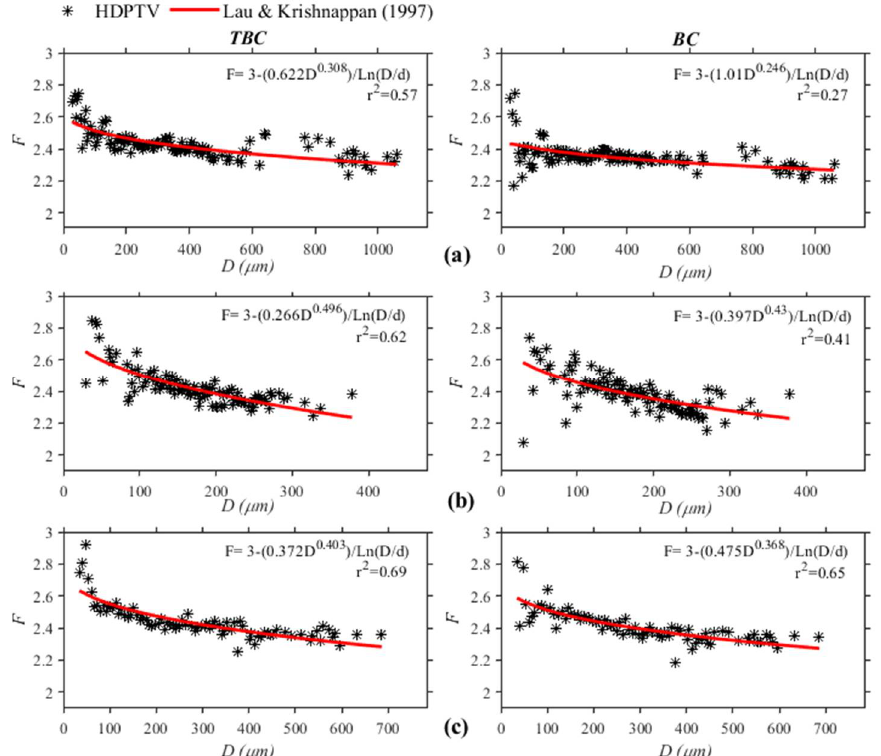
Figure 12. Best fit of the fractal dimension for the Grijalva River with Lau and Krishnappan [15] model at different flocculation times using TBC and BC methods; ( a ) 30 minutes, ( b ) 45 minutes, ( c ) 60 minutes.